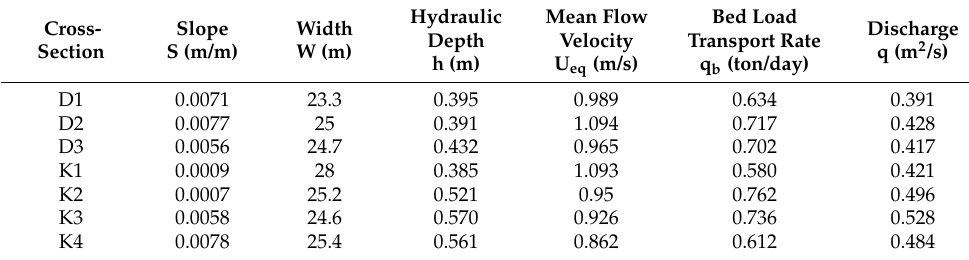
Table 12. Measured parameters in Babolroud River.